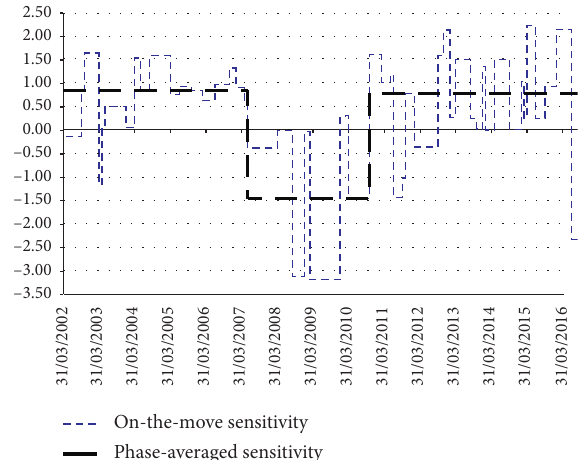
Figure 4: Phase-averaged sensitivity of US BBB-rated bonds,